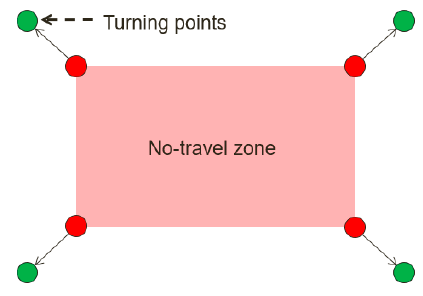
Figure 9. Schematic diagram of the turning points.